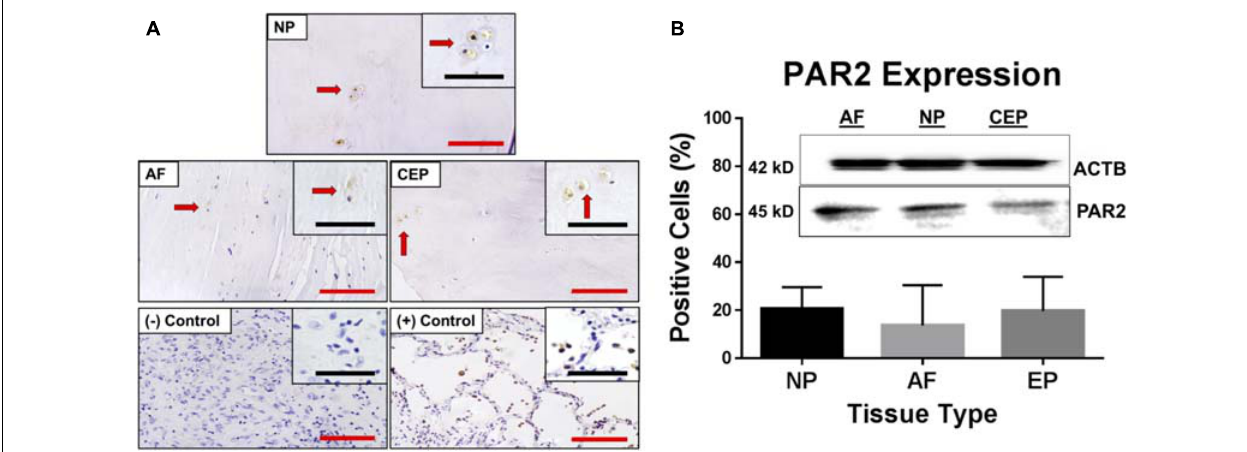
FIGURE 4 | (A) Representative images of immunohistochemical (IHC) PAR2 staining in IVD tissue from all regions; NP, AF and CEP including relevant positive and negative lung tissue controls. (B) PAR2 expression presented as % of cells expressing PAR2 as assessed by IHC and confirmed with western blot using the same PAR2 primary antibodies. Red scale bar = 100 µ m, Black scale bar = 50 µ m. Arrows point to same cells at both magnifications.